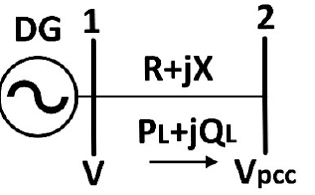
Figure 1. A simplified topology of low-voltage power network.